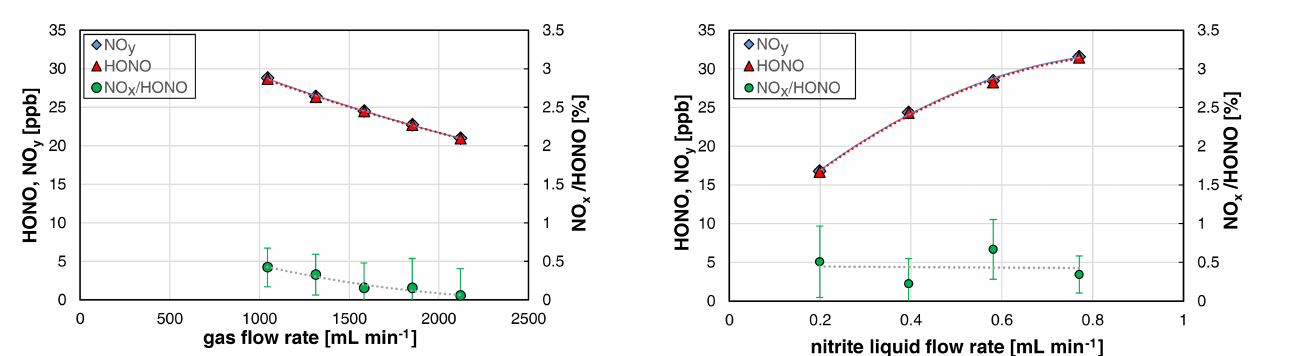
Figure 6. Nitrite liquid flow rate dependence (10, 20, 30, = 0.4mgL − 1 , and 40rpm of the peristaltic pump) of NO y , HONO, and the 2 = 0.4mgL − 1 , NO x / HONO ratio of the HONO source (NO − 2 ∅ , dry = 1570cm 3 min − 1 , pH = 2.47). The error T = 15.9 ◦ C, φ g bars represent the precision errors (2 σ ), which are only visible for the NO x / HONO ratio but smaller than the size of the symbols for HONO and NO y